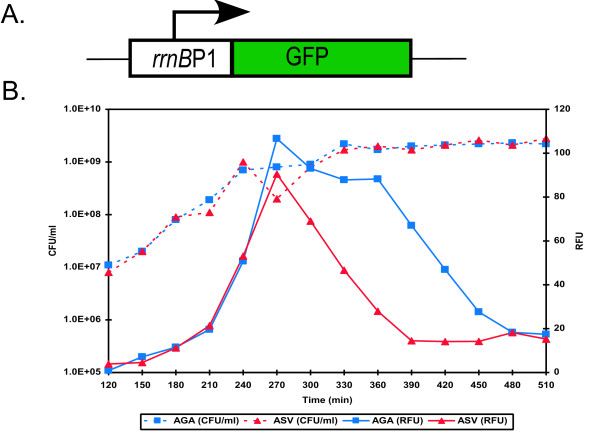
Degradable GFP expression from a ribosomal promoter in a growing culture of E. coli. (A) Graphical representation of the reporter. An unstable variant of GFP was placed downstream of a ribosomal promoter, rrnBP1. (B) Stationary phase cultures of E. coli ASV and AGA, each containing a different variant of unstable GFP, were diluted (1:1000) in fresh media and cultured with aeration at 37°C. At designated timepoints samples were removed and assayed for cell counts (CFU/ml) and fluorescence (RFU, arbitrary units).